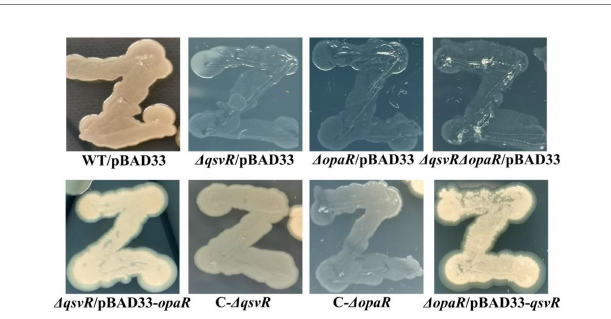
FIGURE 6 The opaque (OP)-translucent (TR) transition of V. parahaemolyticus strains. V. parahaemolyticus strains were grown in M broth at 30 ° C with shaking at 200 rpm overnight, and a small amount of each cell culture was taken with an inoculation loop, streaked directly on a HI plate, and then statically incubated at 37 ° C for 48 h.